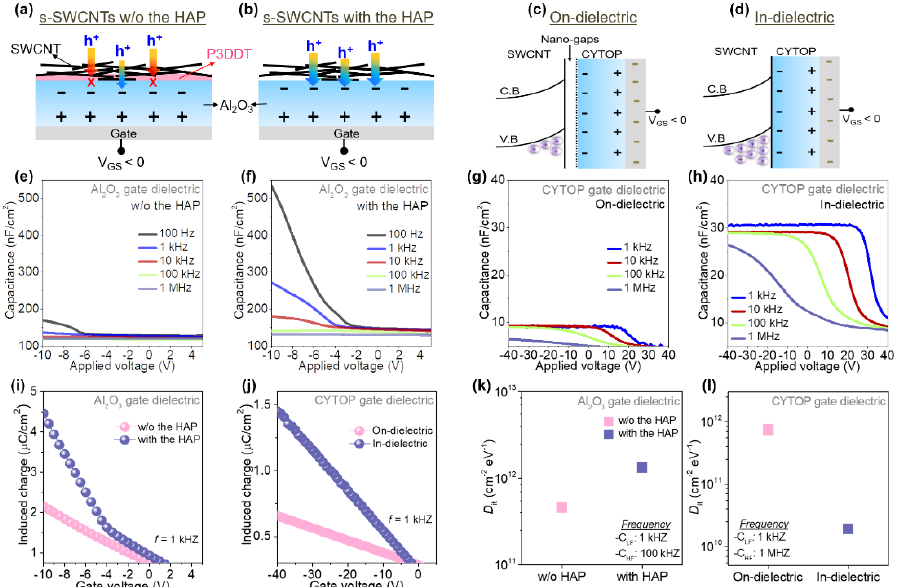
Figure 5. Schematics of the mechanism for the accumulation of hole-carriers in the s-SWCNT ( a ) w/o and ( b ) with the HAP treatment. The energy band diagram models of CYTOP gate ( c ) on- and ( d ) in-dielectric configuration. The C-V characteristics for Al 2 O 3 gate dielectric with ( e ) w/o and ( f ) with the HAP treatment, and CYTOP gate dielectric with ( g ) on- and ( h ) in-dielectric configuration. Induced charge density of the s-SWCNT FETs with ( i ) Al 2 O 3 and ( j ) CYTOP gate dielectric. Interface trap density of the s-SWCNT FETs depending on ( k ) the HAP process and ( l ) device configuration.